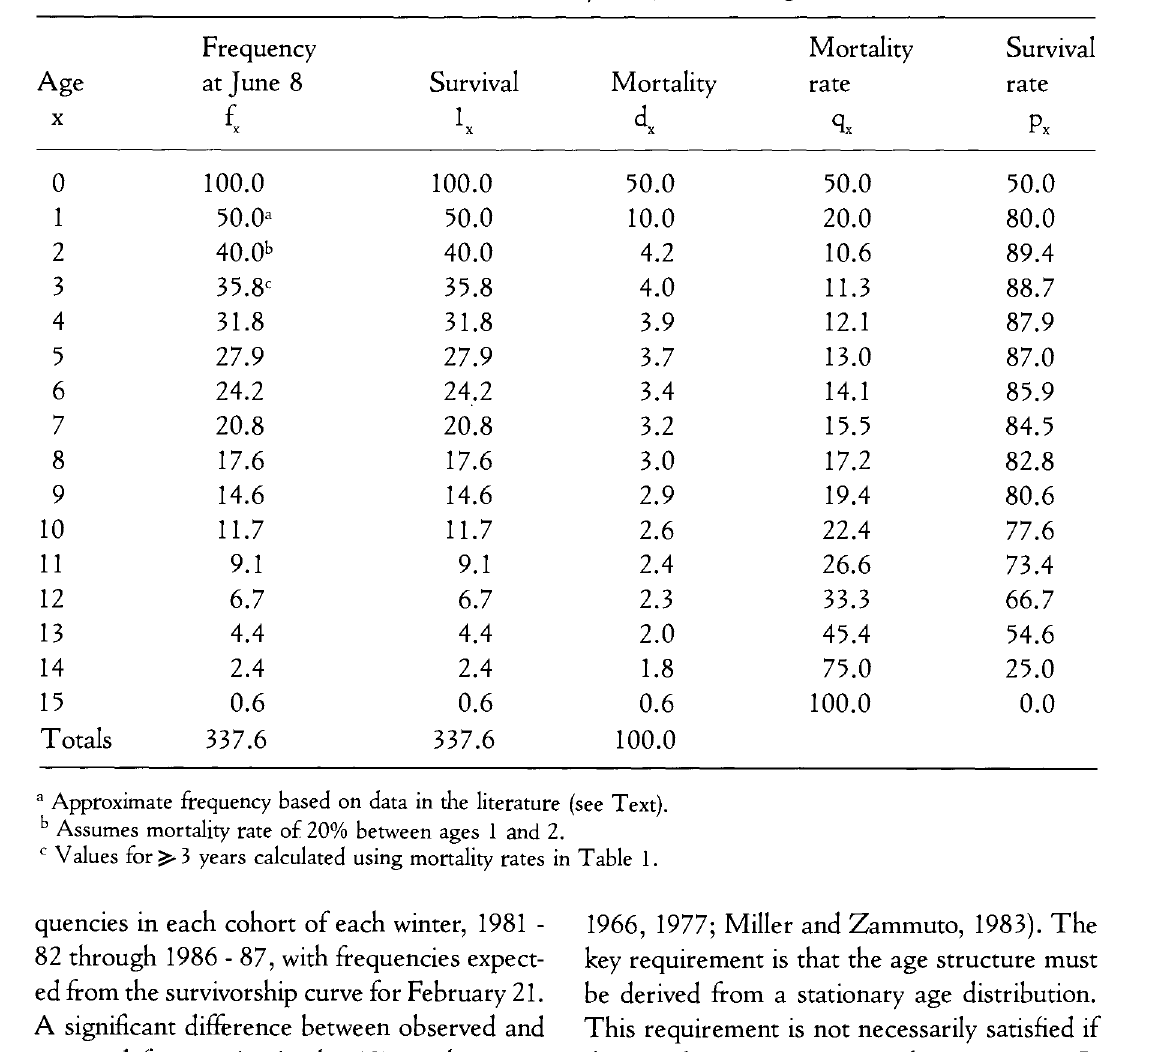
Table 2. A life table for female caribou in the Beverly herd, 1980 through 1987. Frequency Mortality